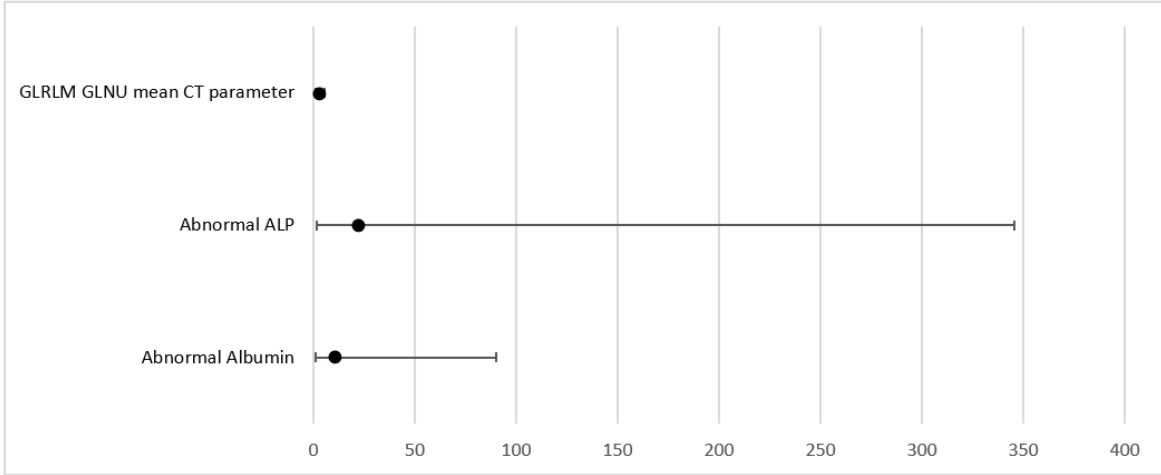
Figure 4. Forrest plot for MVA model correlating with PFS.